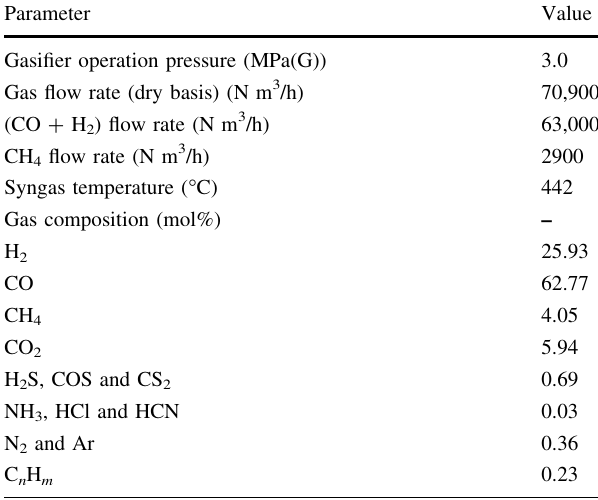
Table 3 Commercial gasifier operation